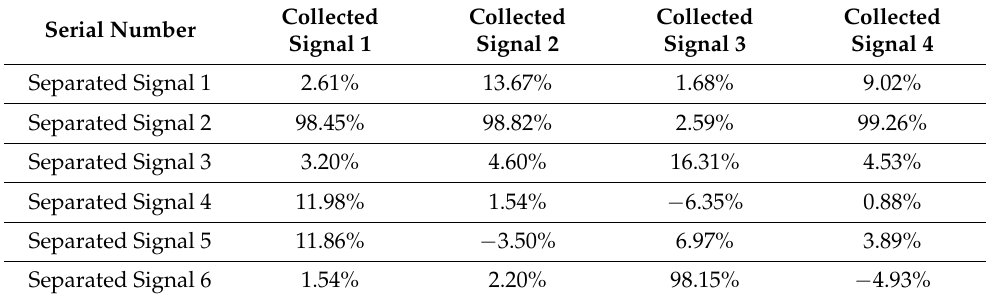
Table 3. Similarity factor between the separated signals and the collection signals 1–4.